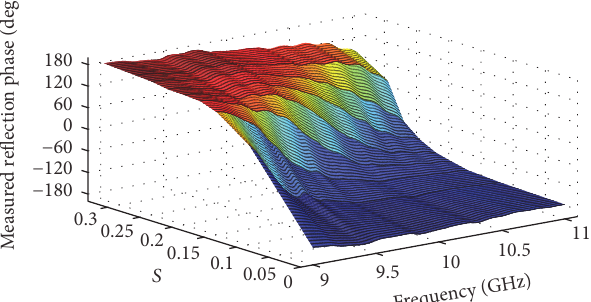
Figure 19: Measured phase curve versus frequency and scaling factor 𝑆 ( 𝐿 = 7.6 mm, Δ𝑥 × Δ𝑦 = 0.3𝜆 0 × 0.3𝜆 0